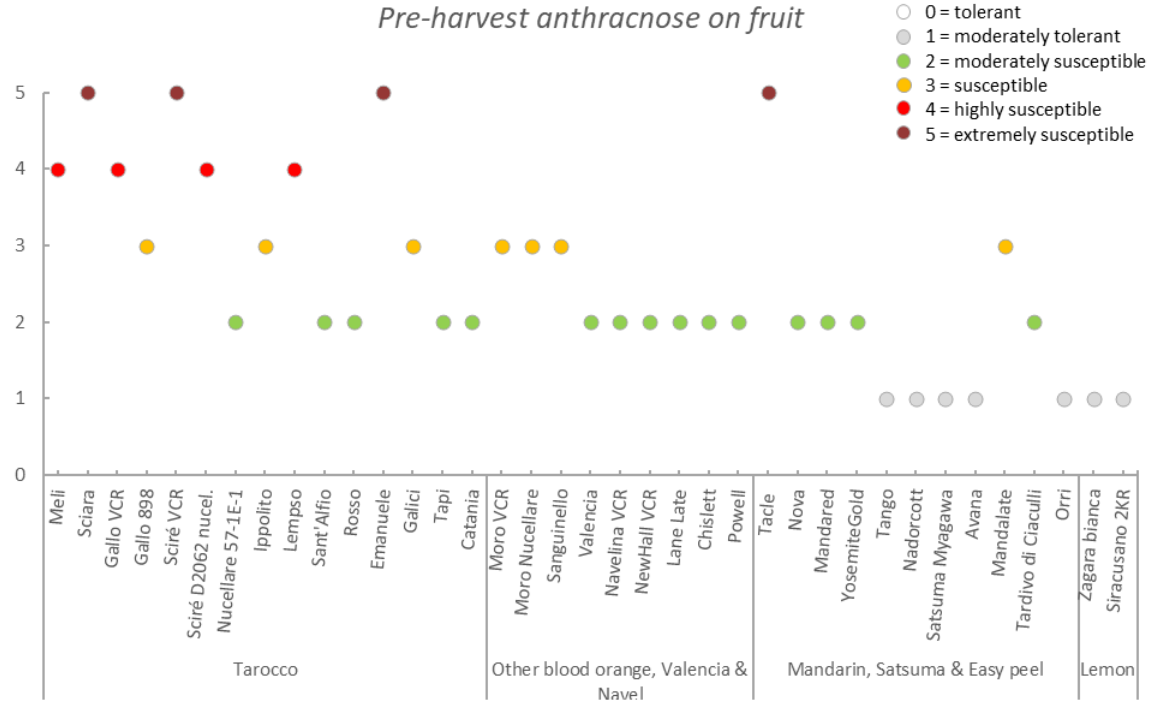
Figure 10. Maximum potential infection risk of pre-harvest anthracnose on fruit recorded on detected Citrus germplasm. Data obtained from several Sicilian citrus production areas (from 1-to-20) within Citrus groups surveyed for three periods intercepting an eleven-year survey.